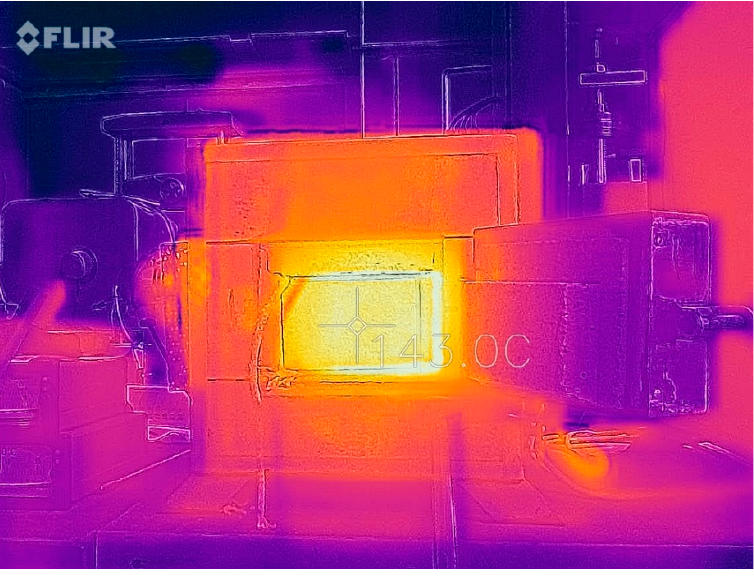
Figure 3. Sample photo of the measurement of thermal radiation.